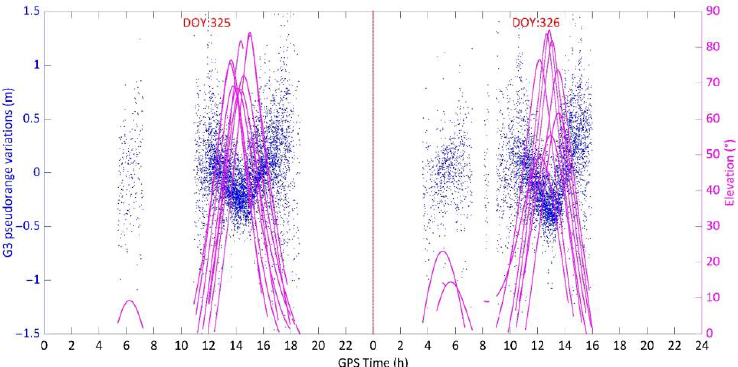
Figure 8. The code pseudorange variations of R21 on DOY 325 and 326, 2020, at nine South American stations. The blue dots denote the code pseudorange variations calculated by the CMC combination, the purple line denotes the elevation angle, and the vertical red line is the dividing line between DOY 325 and